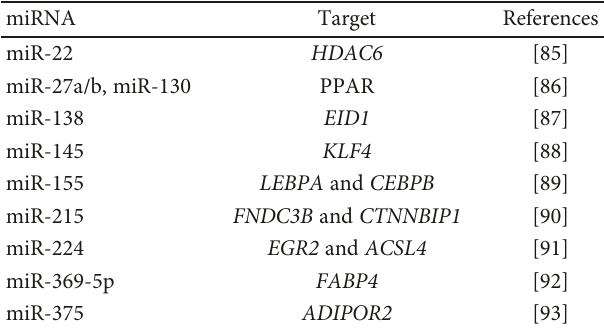
3: miRNAs associated with di ff erentiation